Question: Name the type of graph shown.
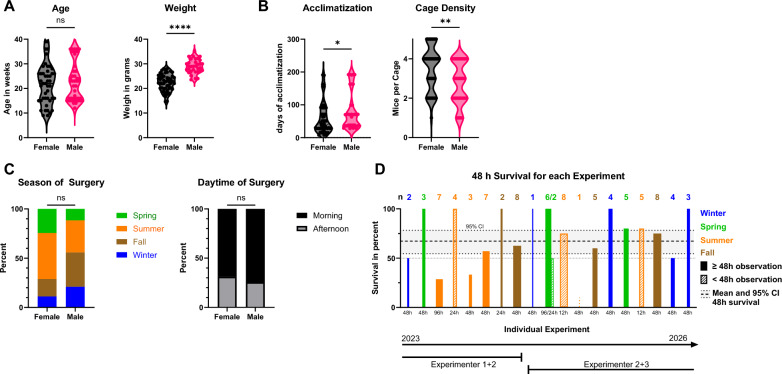
Answer: box